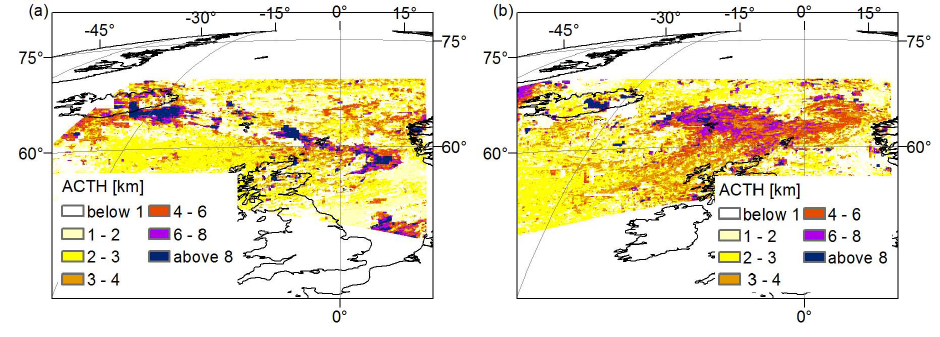
Fig. 8. Another example of ACTH on 15 April at 11:35UTC (a) and on 19 April at 12:51UTC (b) .